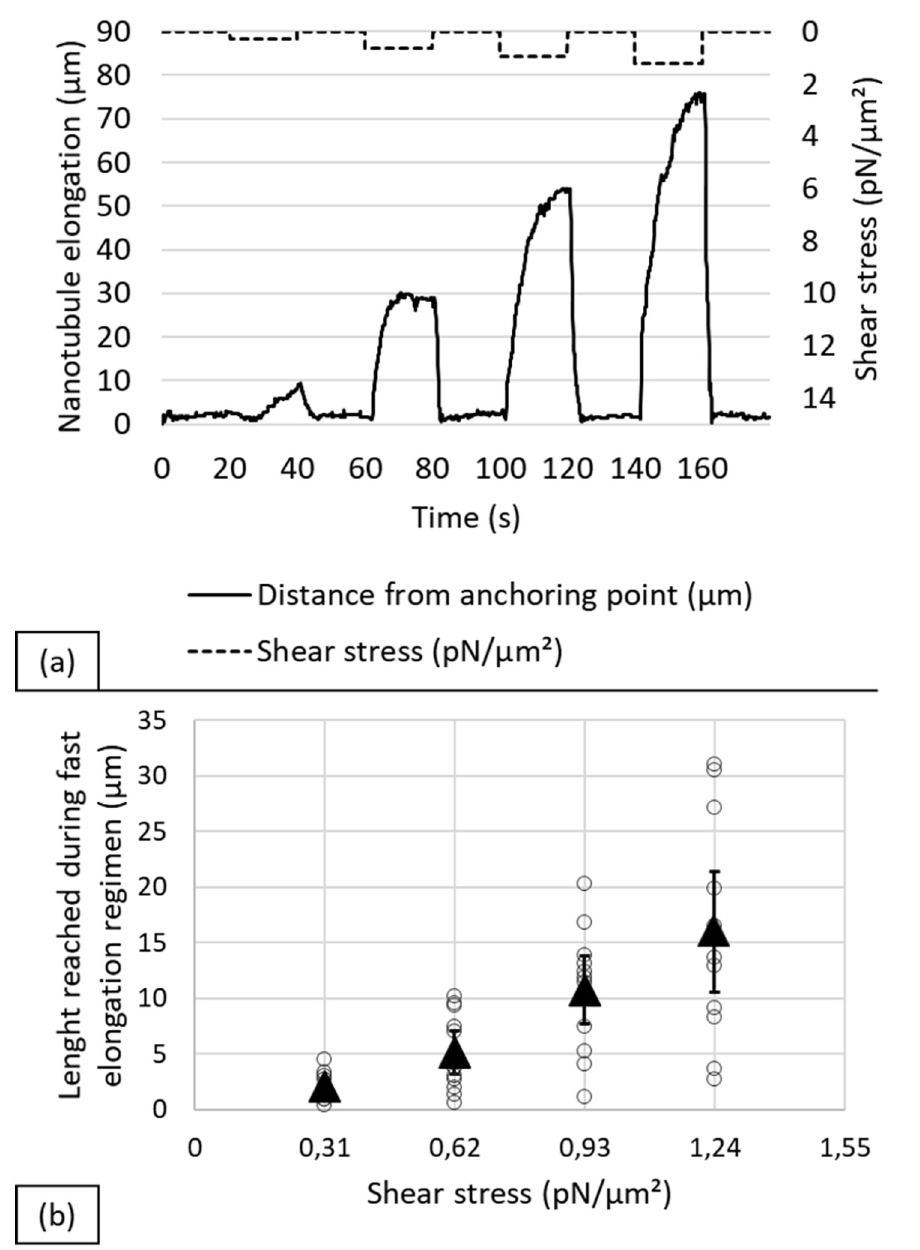
Fig 5. (a) Elongation of an epimastigote with increasing shear stress: Starting with 20 secs of no flow, parasites were subjected to a shear stress cycle of 0.31 –– 0.62–0.93–1.24 pN/ μ m 2 pulses; each pulse was 20 s long, followed by a pause lasting 20 s. The curve shows the length of the nanotubules, as measured by changes in position of the flagellum tip. (b) Average extension as a function of shear stress. White circles correspond to the average length reached by each parasite during the fast elongation phase (first 2–4 s) after pulse introduction (n = 12); black triangles represent average data (data available in S1 Dataset). (S3 Movie). When shear stress was applied again at 1.24 pN/ μ m 2 (Fig 7D), the parasite acquired a “V” shape with a vertex in the middle of the parasite, indicating the migration of the neck of the nanotubule to a location near the flagellar pocket.